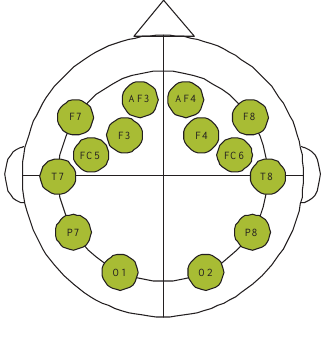
Figure 2. The 10–20 electrode positioning supported by EMOTIV